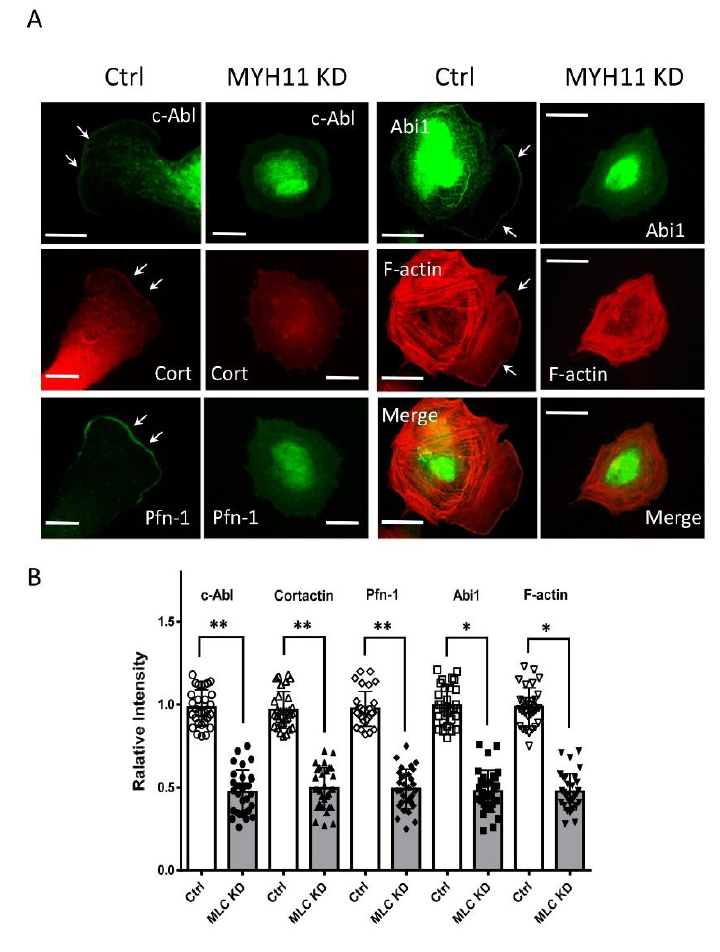
Figure 4. MYH11 orchestrates the positioning of c-Ab, cortactin, Pfn-1, and Abi1 to the cell edge. ( A ) Ctrl and MYH11 KD cells were plated onto collagen-coated coverslips for 30 min followed by immunofluorescence and fluorescence analysis. The arrows point to the leading edge. Scale bar: 10 µ m. ( B ) Data are mean values of experiments from at least 20 cells for each group. Error bars indicate SD. One-way ANOVA was used for statistical analysis. ** p < 0.01; * p < 0.05.